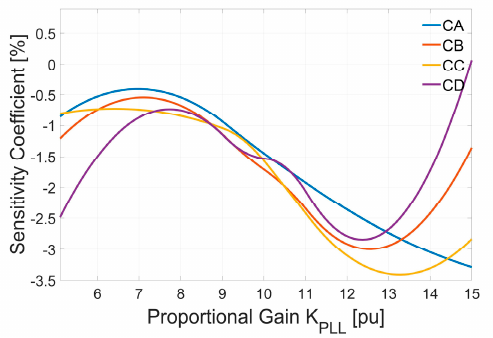
damping ξ e (TNF 1 ) related to K PI .